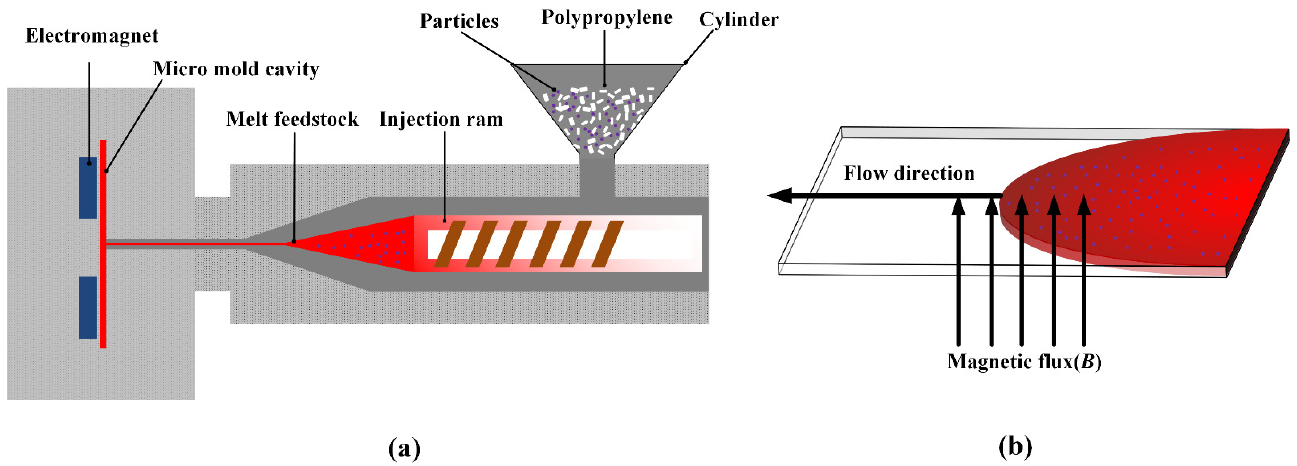
Figure 1. ( a ) Schematics of injection molding process under an external magnetic field, ( b ) schematics of magnetic field direction and melt filling direction, the B is the magnetic flux density.